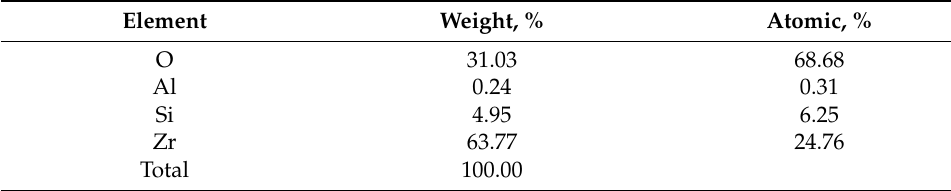
Table 2. Elemental proportions in point 2 of the sample #4.